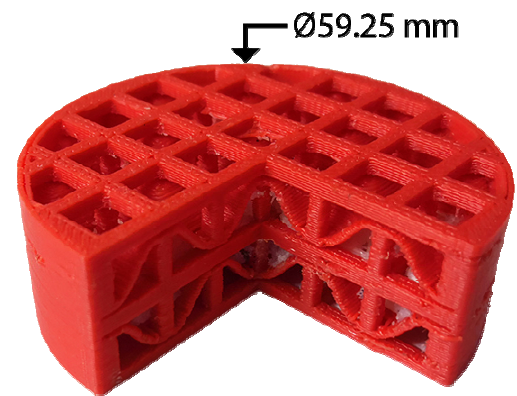
Figure 29. 3D printed structure built with the unit